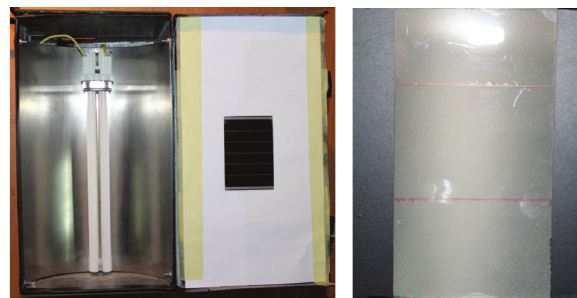
Figure 2: Testing apparatus of leaf area measurement showing placement of lamp, parabolic reflector, and solar module.